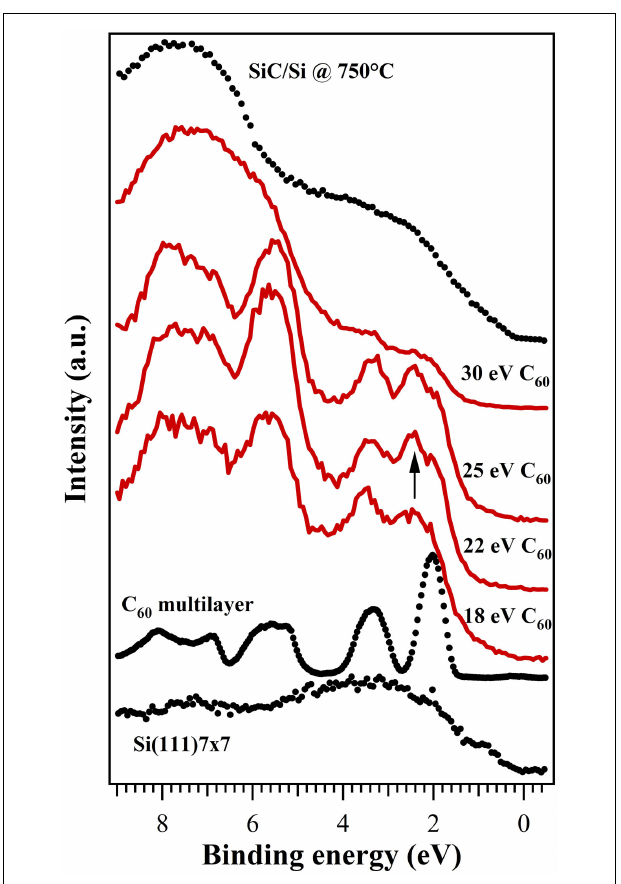
FIGURE 3 | VB spectra of submonolayer films of C 60 at different kinetic energies (18, 22, 25, and 30eV) and at a process temperature of 500°C . For reference, VB spectra from a 3C– SiC film, the clean Si substrate, and a C 60 multilayer are also reported. Spectra are plotted with a vertical shift to better compare